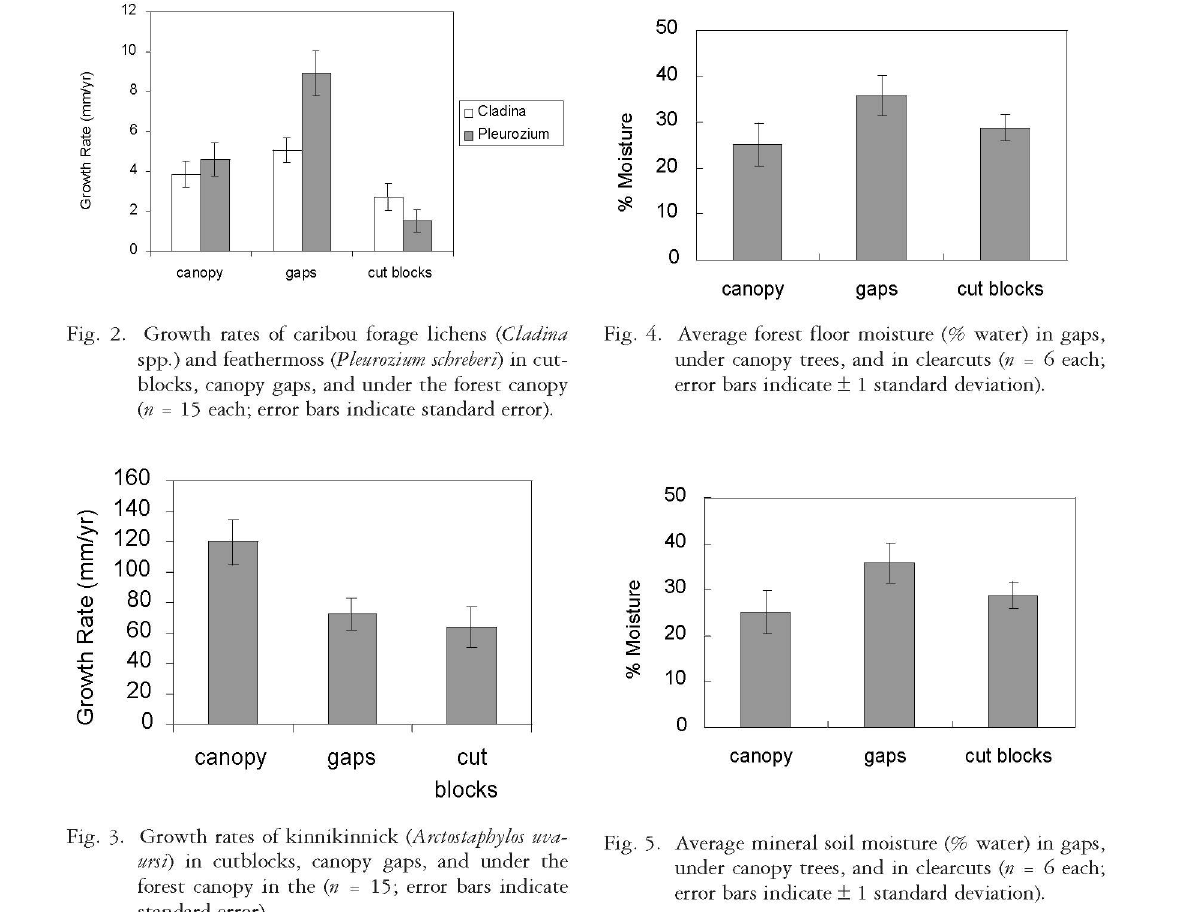
Fig. 5. Average mineral soil moisture (% water) in gaps, under canopy trees, and in clearcuts (n = 6 each; error bars indicate ± 1 standard